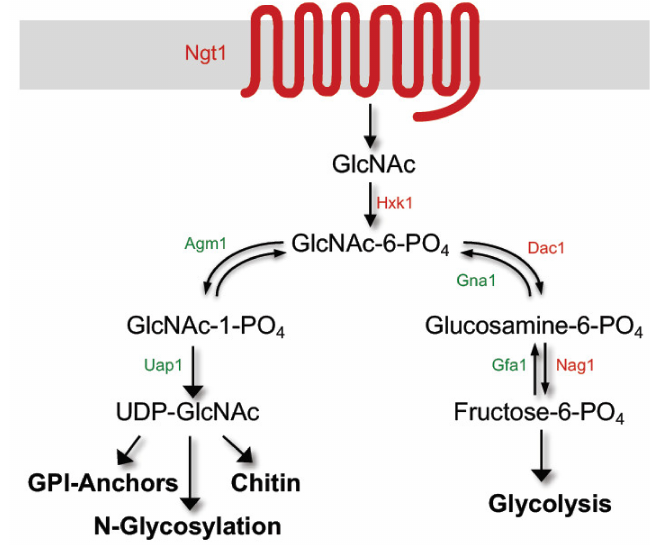
Figure 1. GlcNAc metabolic pathways in Candida albicans . Catabolic proteins are indicated in red and anabolic proteins are indicated in green. Arrows indicate the direction of the biochemical activity. GlcNAc is transported into the cell by Ngt1 and then phosphorylated by Hxk1. It can then be converted into fructose-6-PO 4 and metabolized. Alternatively, GlcNAc-6-PO 4 can enter the anabolic pathway and be converted into UDP-GlcNAc, a key building block of cell wall chitin, GPI-anchors on proteins, and N -glycosylation of proteins. Note that cells only synthesize GlcNAc-6-PO 4 so the presence of non-phosphorylated GlcNAc can act as a unique signal for the presence of exogenous